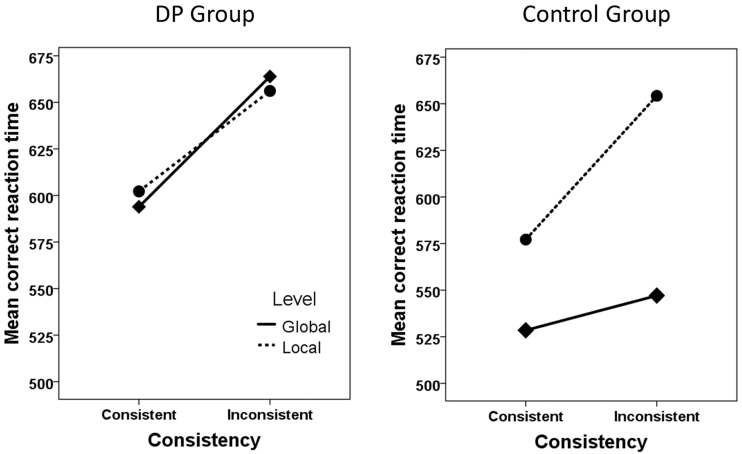
Illustration of the performance for the DP group and the control group in the four conditions of the Navon paradigm.